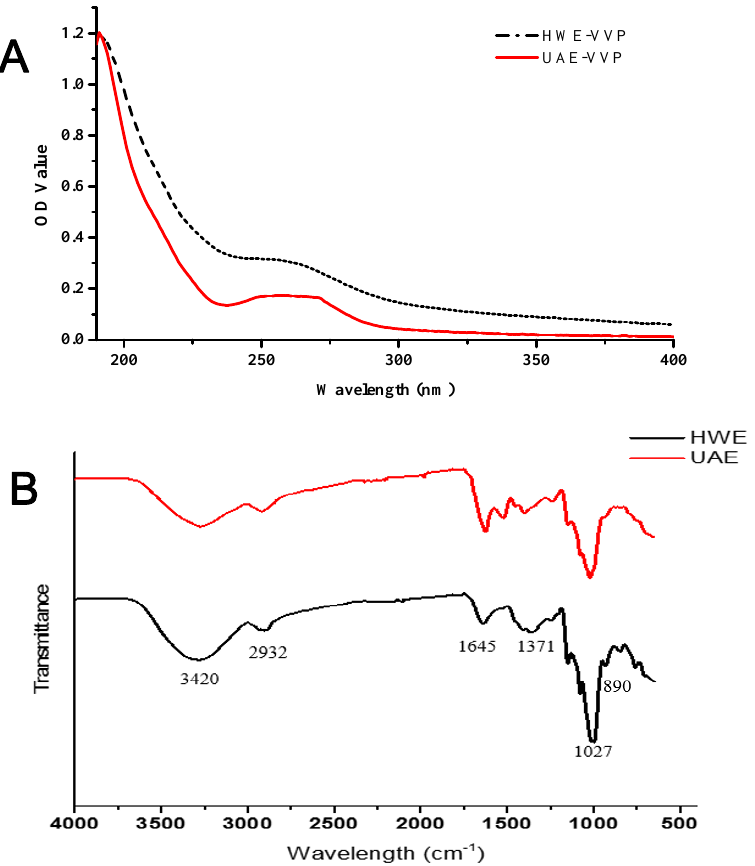
Figure 3. UV spectrograms ( A ) and Fourier transform infrared spectra ( B ) of HWE ‐ VVP and UAE ‐ VVP.